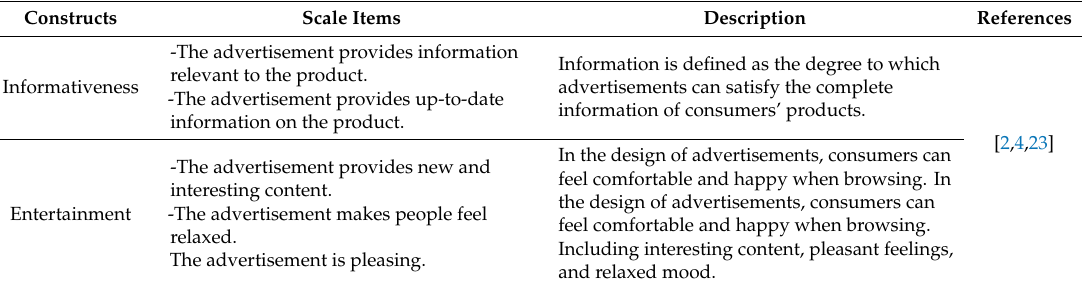
Table 3. The technical